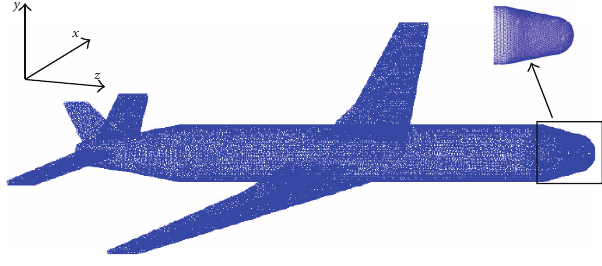
Figure 9: Mesh of the PEC aircraft-like model.